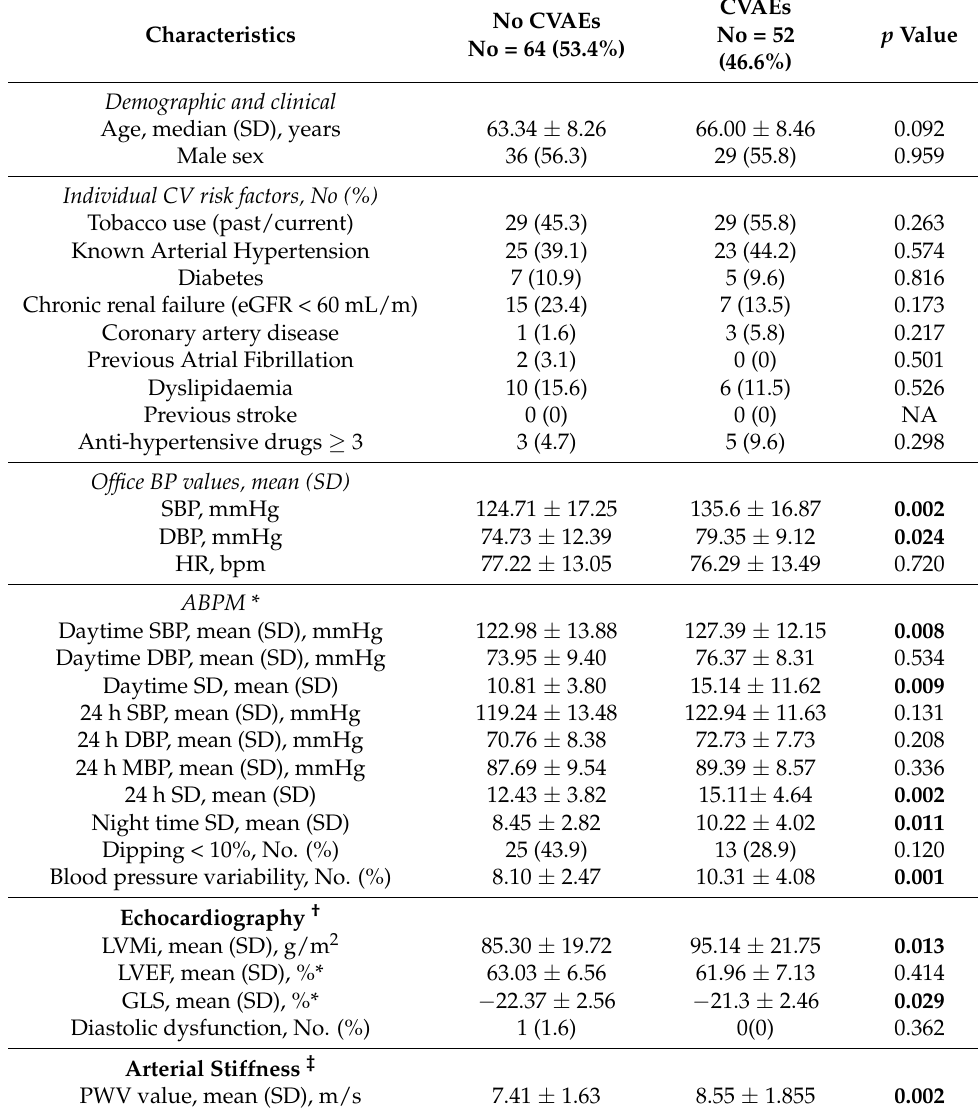
Table 3. Comparison between no-CVAEs and CVAEs groups: main baseline parameters.